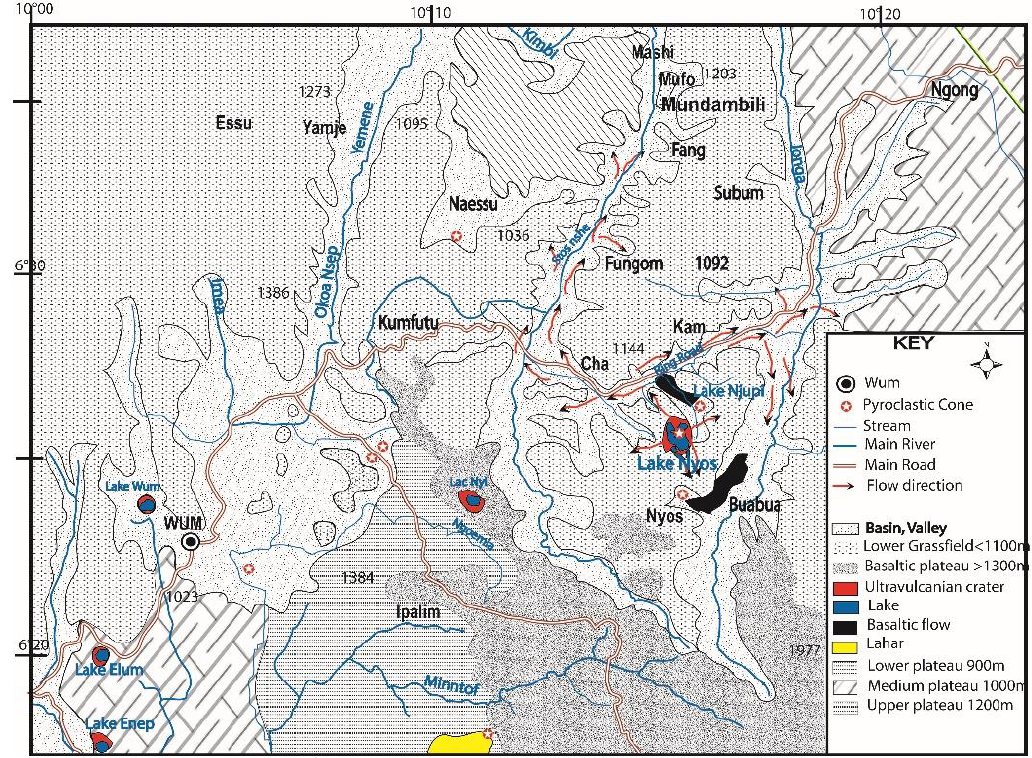
Figure 3. Lake Nyos topographic features, with arrows indicating the direction of the gas and water reverse back according to the prevailing wind direction (Source: [8,20], modified). The map shows the main village affected by the disaster, as well as the resettlement camps.